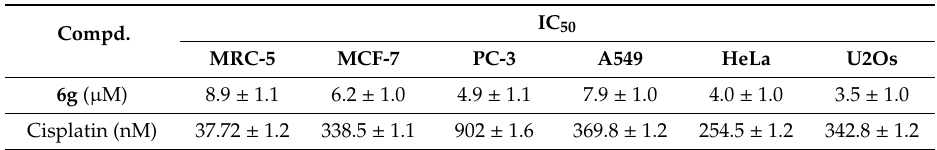
Figure 3. Primary antiproliferative e ff ect of the steroidal D-ring-fused 5-aminopyrazoles on di ff erent cancerous cell lines and on MRC-5 fibroblasts represented as heat map {compound = 5 µ M; 72 h incubation time}. Control represents the viability of cells receiving no treatment. Table 3. IC 50 ( ± SD) values of compound 6g and of cisplatin assessed on noncancerous MRC-5 cells and on various cancer cell